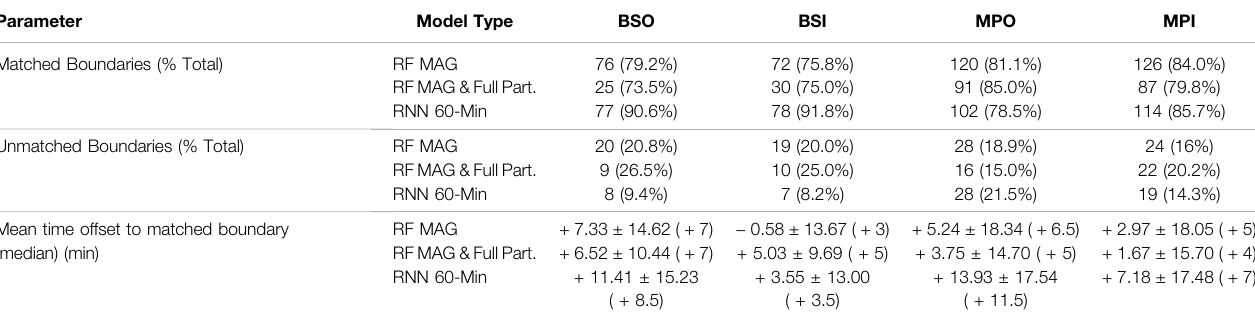
TABLE 4 | Performance of the RF MAG, RF MAG & full particle, and 60-min RNN model at correctly detecting labeled boundary crossings. A boundary crossing was considered “ matched ” if there was the same type of boundary in the model predictions within one hour of the labeled crossing. The mean time offset of the matched boundaries is positive if the detected boundary crossing occurred after the labeled boundary (i.e., the model was delayed in its prediction). Noted is the shorter length of the RF MAG & full particle test set (extending only through 2012) and fewer labeled boundary